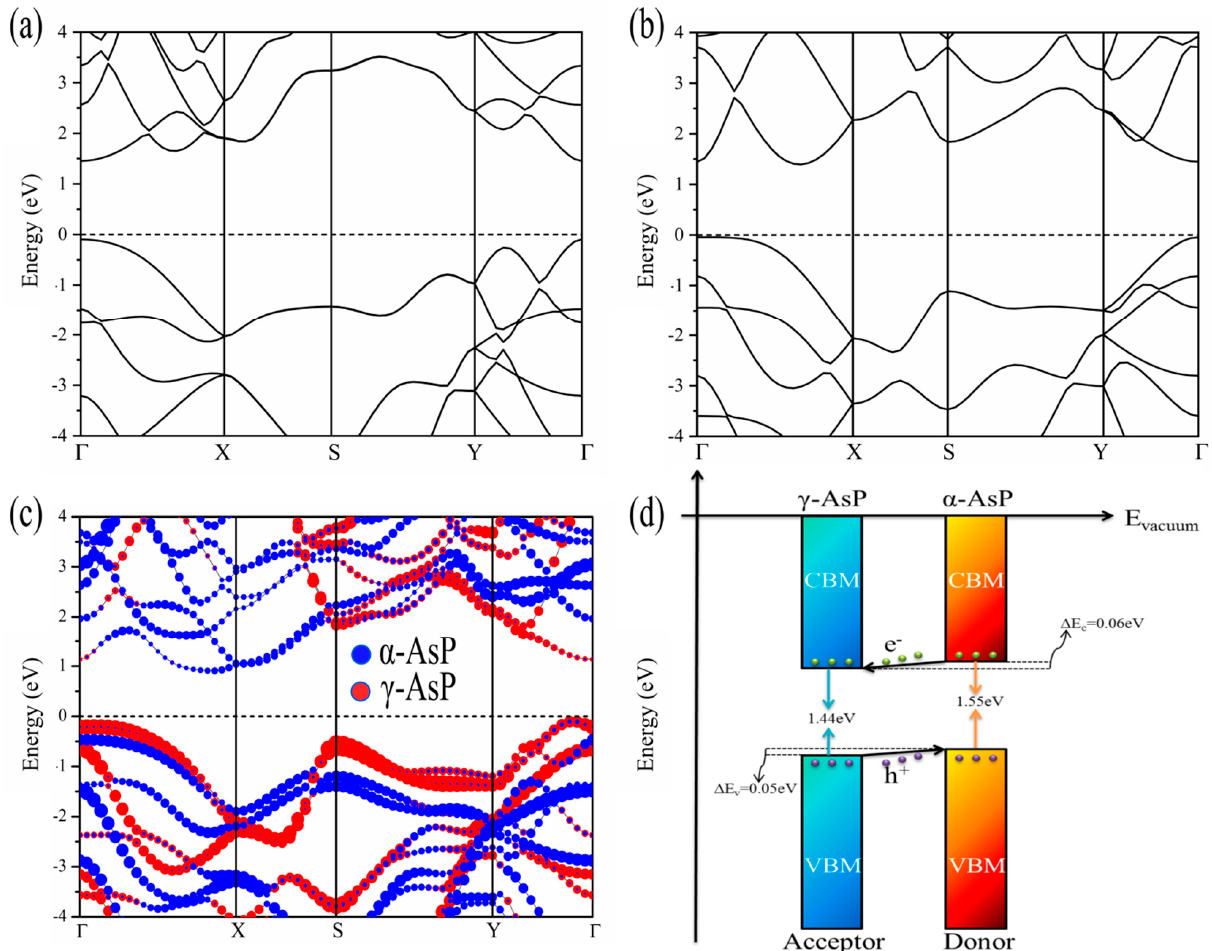
Figure 2. The band structure of the α -AsP monolayer ( a ) and γ -AsP monolayer ( b ). ( c ) Projected band structure of the α -AsP/ γ -AsP homojunction. The blue and red circle size reflects the weight of α -AsP and γ -AsP in the band structure of the α -AsP/ γ -AsP homojunction. ( d ) Band alignment of the α -AsP/ γ -AsPhomojunction. The above calculations are based on the calculations of HSE06 function. The work function (WF) of each component layer in the α -AsP/ γ -AsP homojunction is a critical factor for the band alignment. The work function is calculated by using the formula Φ = E vac − E F , where E vac is the vacuum level. E F is the Fermi level of the studied monolayer, and α -AsP/ γ -AsP homojunction are 4.81 eV, 4.82 eV, and 4.71 eV,